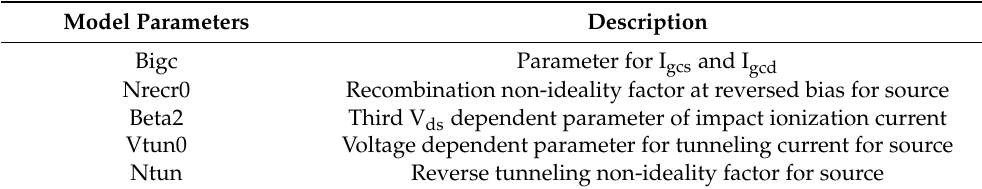
Table 1. Some model parameters of